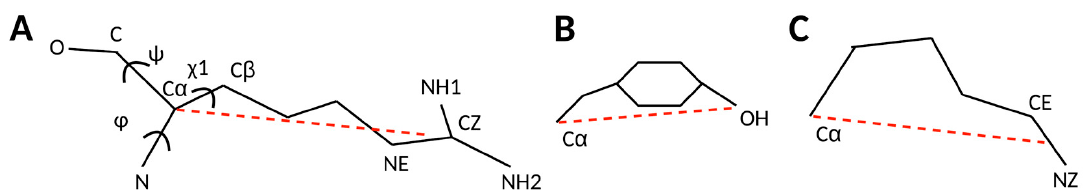
Figure 4. The four features— φ , ψ , χ 1 , and block length. The block length (dashed line) was calculated using the center of the distal block of the side chain, illustrated for ARG ( A ), TYR ( B ) and LYS ( C ). Four data sets (X-ray-1.5, EM-2-4, EM-4-6 and X-ray-237) were created (see Results). For those